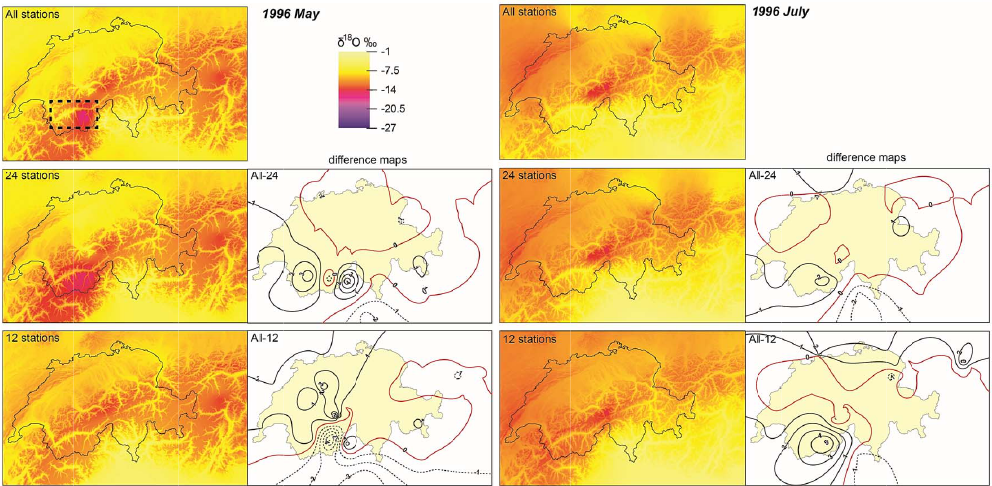
Fig. 4. Precipitation oxygen isoscapes for Switzerland derived for May 1996 and July 1996. Dashed rectangle frames Valais. For further explanation see the caption of Fig. 3.